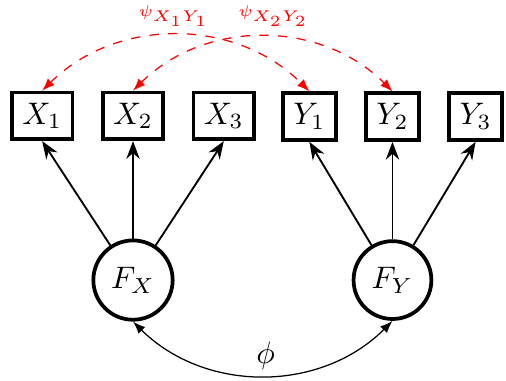
Figure 3. Simulation Study 1: Data-generating model. Residual correlations are displayed with curved dashed red double